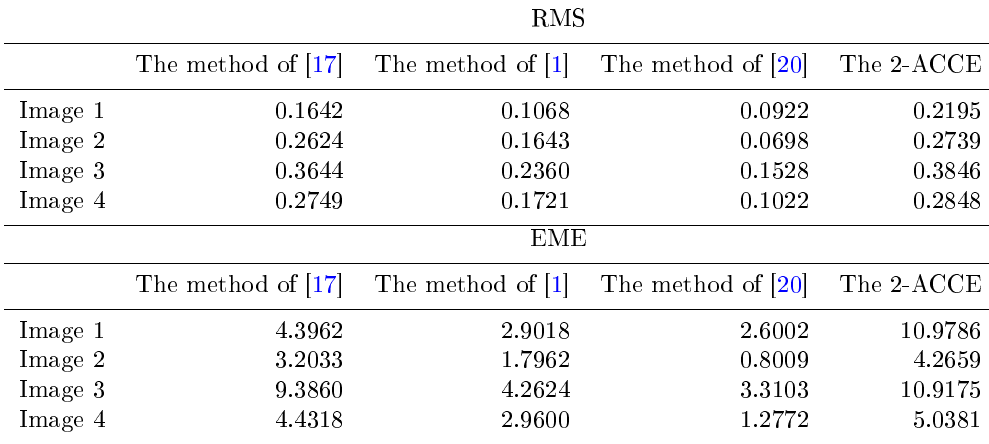
Tab. 3: Results of comparative